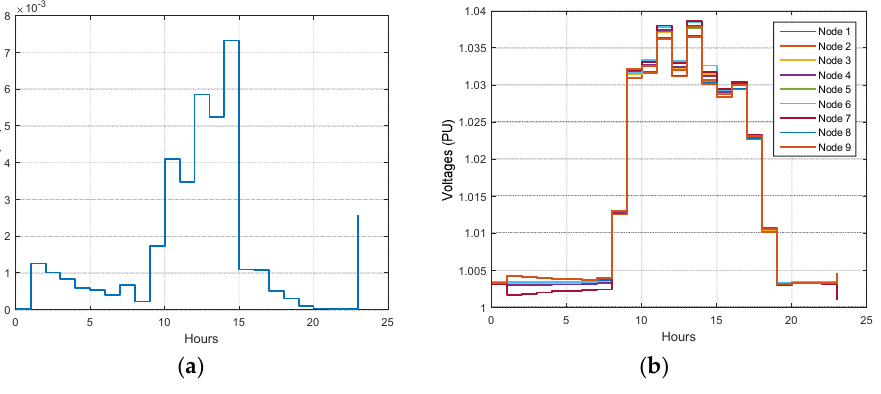
Figure 13. Total active power losses and bus voltages for a summer day. ( a ) Active power losses; ( b ) Bus voltages.